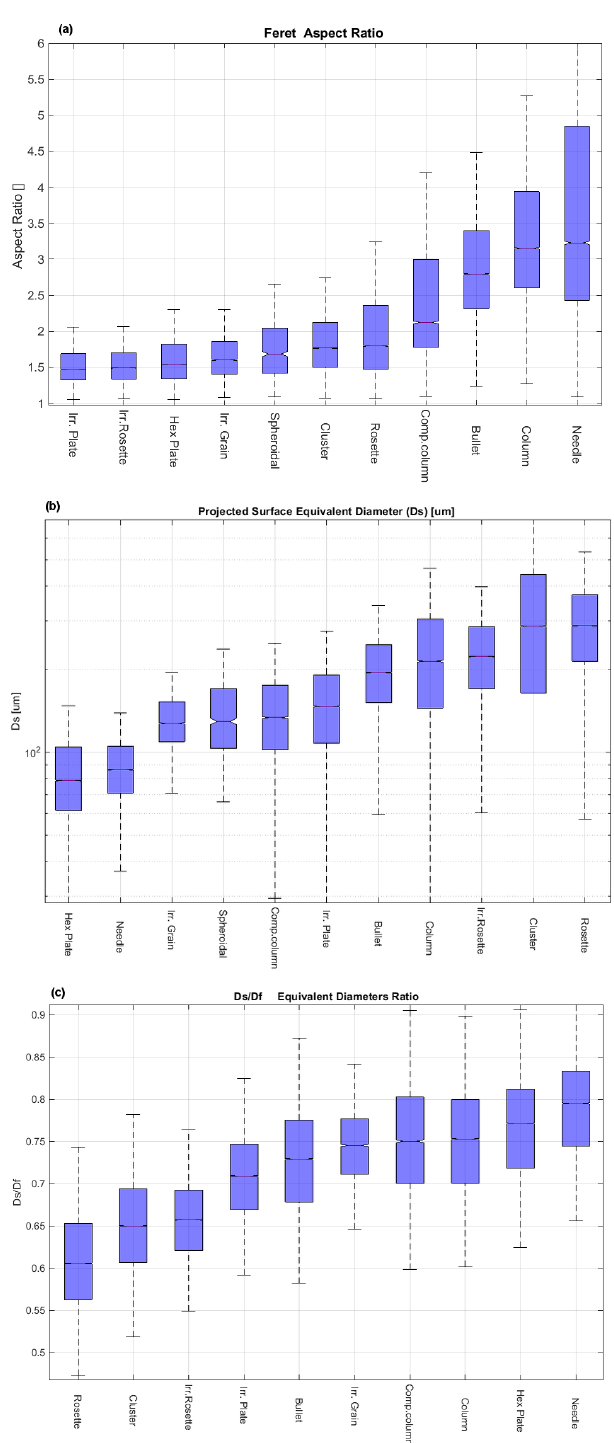
Figure 23. Statistics of (a) aspect ratio, (b) projected surface- equivalent diameter ( D s ), (c) ratio between surface-equivalent ( D s ) and Feret-box-equivalent ( D f ) diameters for the years